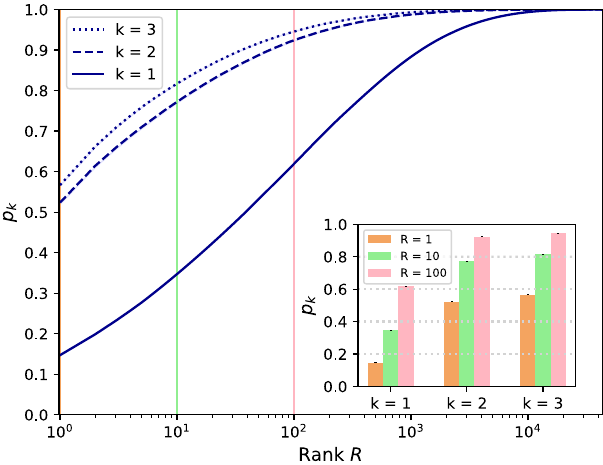
Fig. 2 Probability of identi fi cation. For each k ∈ {1, 2, 3}, we plot p k , the probability of identi fi cation within rank R ∈ {1, … , 43, 606} when the time delay is D = 1 week, with the 95% con fi dence interval shown in light blue. (Inset) shows the probability of identi fi cation for ranks 1, 10, and 100, with error bars for the 95% con fi dence interval. Our model correctly identi fi es people 52.4% of the time for k = 2. The probability of correct identi fi cation is still high at p k = 1 = 14.7% for k = 1 and slightly increases p k = 3 = 56.7% when k increases from 2 to 3. Our model ranks the correct candidate among the top 10 predictions p k = 2 = 77.2% of the time and among the top 100 predictions p k = 2 = 92.4% of the time for k =